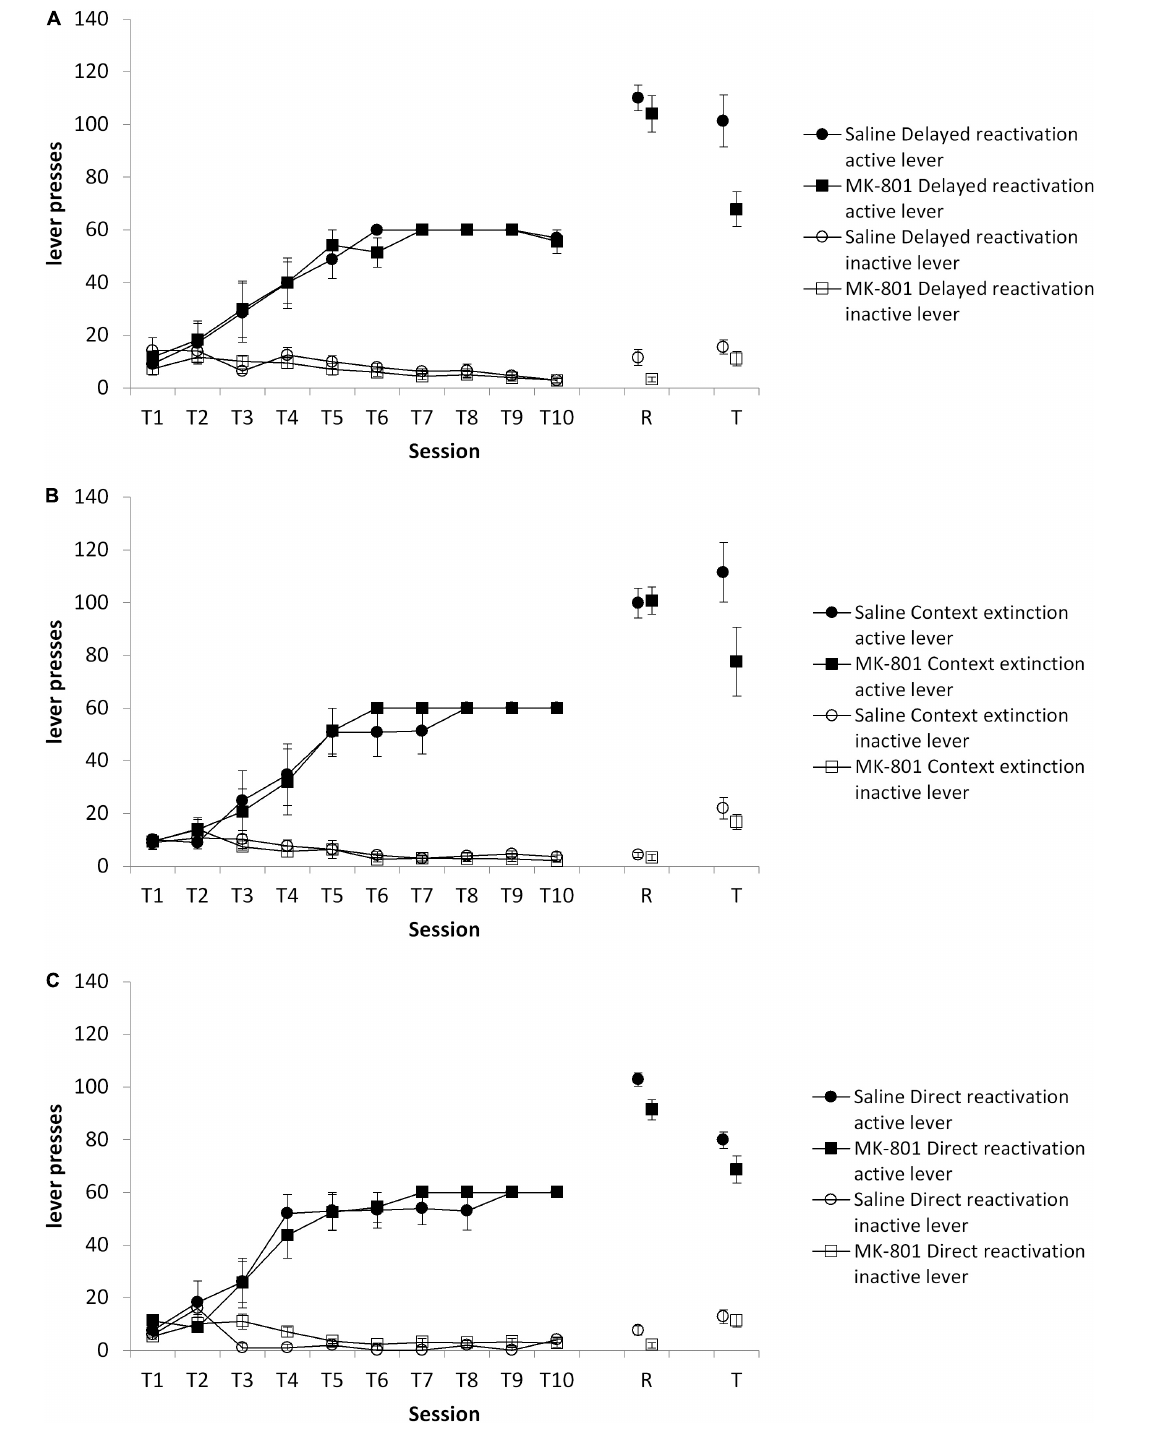
FIGURE3 Discriminated lever pressing at test (T) was impaired in the delayed reactivation condition, but not the context extinction and direct reactivation conditions. Rats were trained to press an active lever for sucrose reward across 10 days (T1–T10) and then received a VR5 reactivation session (R) following MK-801 or Saline injection. (A) In the delayed reactivation condition previously MK-801 treated rats ( n = 7) showed significantly impaired discriminated lever pressing compared to Saline-treated control ( n = 7). No differences were observed during training or at reactivation. (B) In the context extinction condition, there was no obvious difference between MK-801 ( n = 5) and saline ( n = 6) treated rats across any phase of the experiment. (C) In the direct reactivation condition, there was also no obvious difference between MK-801 ( n = 8) and saline ( n = 8) injected rats. Data are presented as mean ±